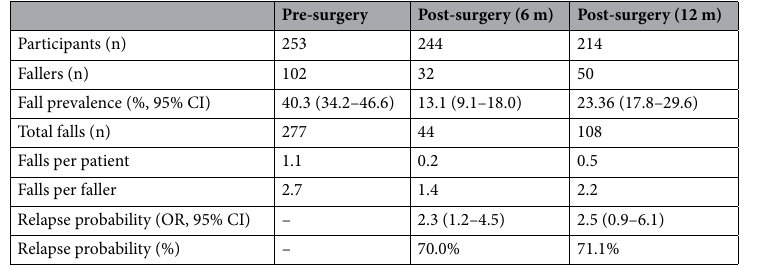
Table 2. Fall descriptors.